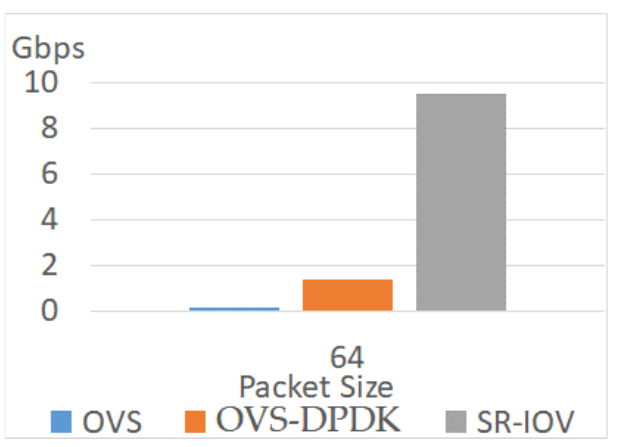
Figure 11. Throughputs of different technologies in PVP scenario when packet size is 64.